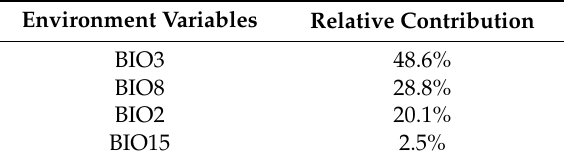
Table 1. Relative contribution of each environmental variables to MaxEnt